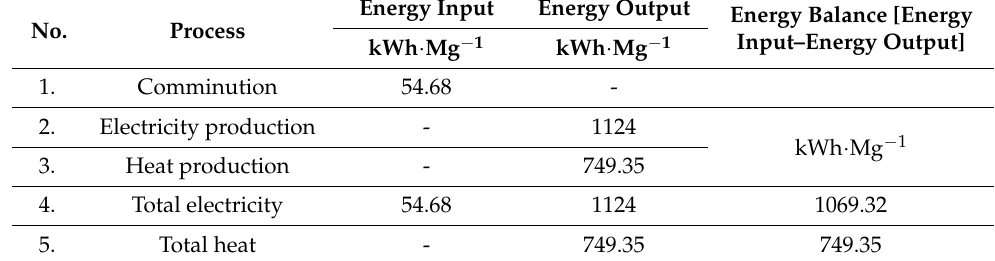
Table 9. The energy balance of biogas generated from comminuted Silphium perfoliatum L.